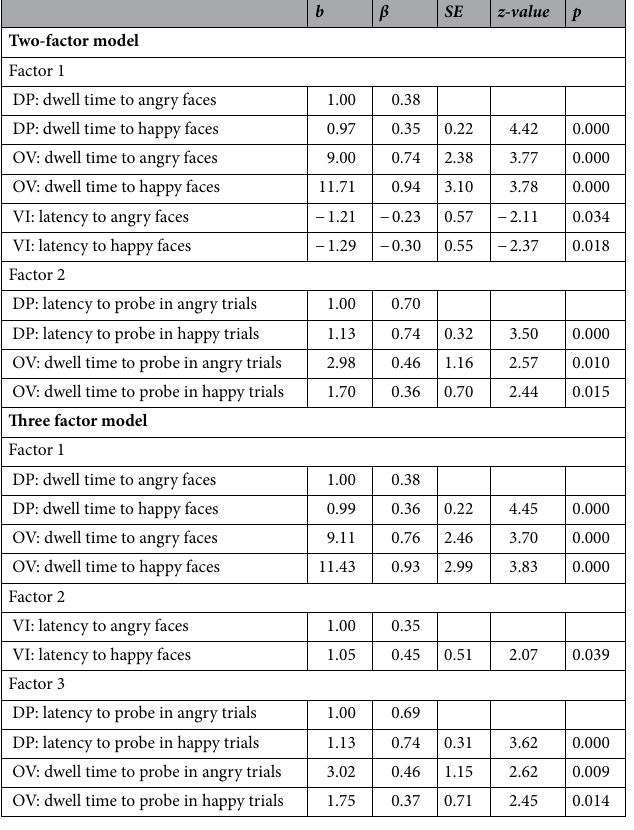
Table 1. 1-, 2- and 3-Factor models assessing affect-biased attention across tasks. N = 193. SE standard error.